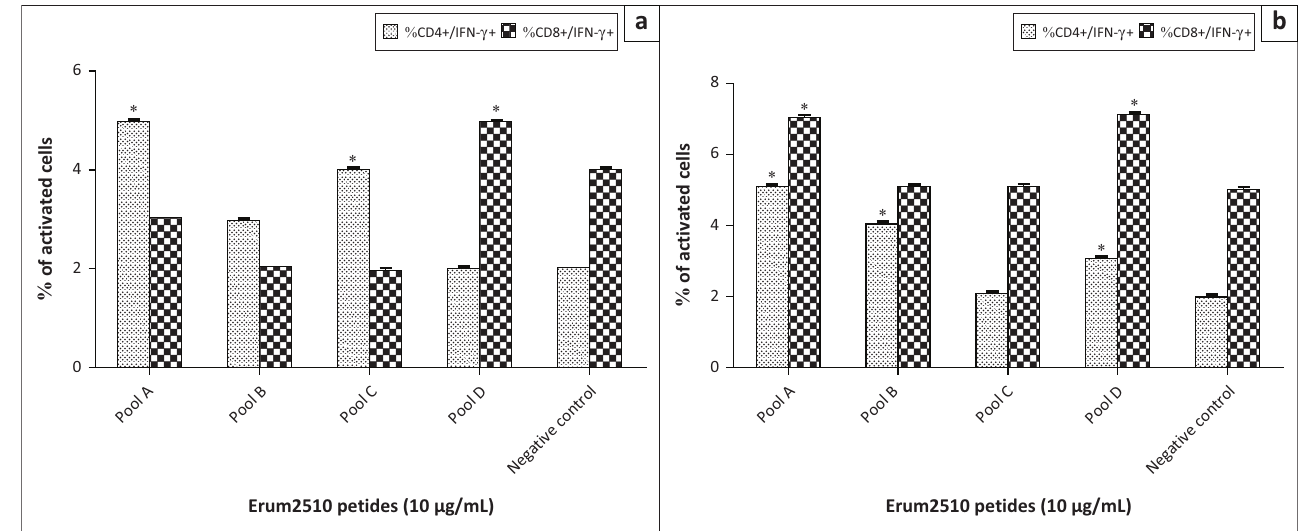
FIGURE 5: Average percentage of peripheral blood mononuclear cells (PBMC) from s6823 (a) and sM2 (b) that stained positive for CD4 and interferon gamma (IFN- γ ), and CD8 and IFN- γ expression markers after stimulation with Erum2510 peptide pools. Peripheral blood mononuclear cells were stimulated with 10 µg/mL protein and incubated for 72 h, after which the percentage of cells was determined by flow cytometry. Unstimulated PBMCs were included as negative control.